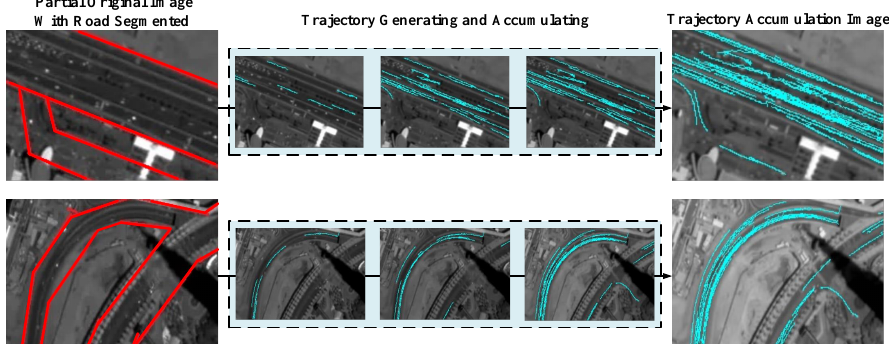
Figure 3. The process of trajectory generation and accumulation. Two roads of the original image are segmented. The trajectories are generating and accumulating with time, the final trajectory accumulation image is displayed on the right, and the trajectories have occupied the road